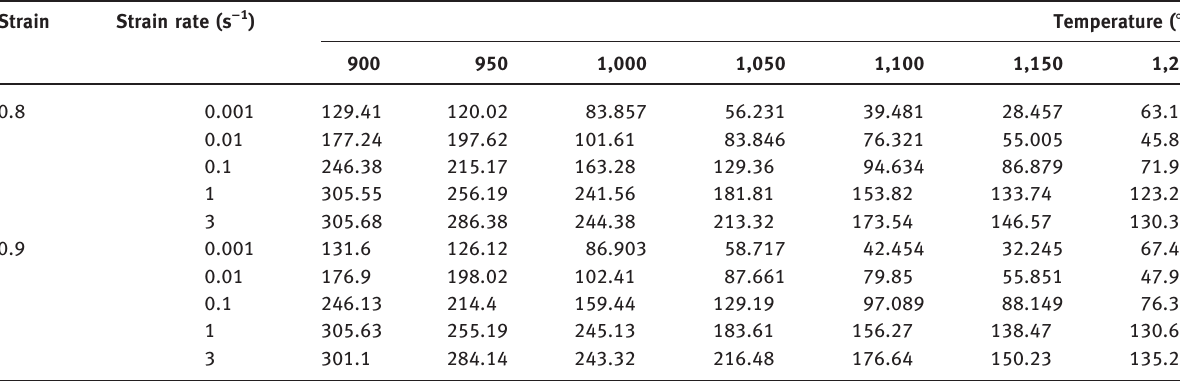
Table 2: Flow stress value of A100 under different deformation conditions. Strain Strain rate (s −  )